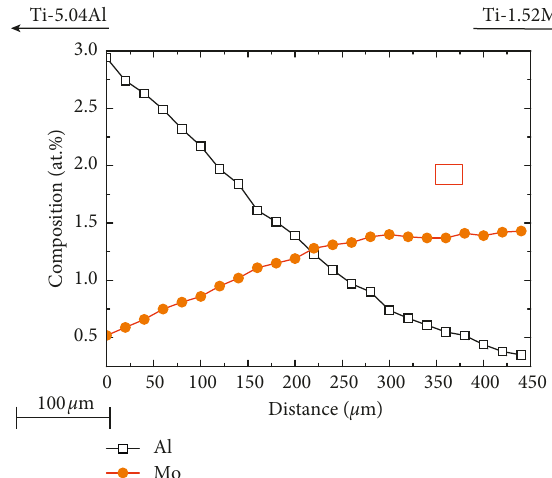
Figure 1: Compositional dependence of the microstructure in the Ti-5.04Al/Ti-1.52Mo diffusion couple after 12h annealing at 1250 ° C followed by the secondary heat treatment.